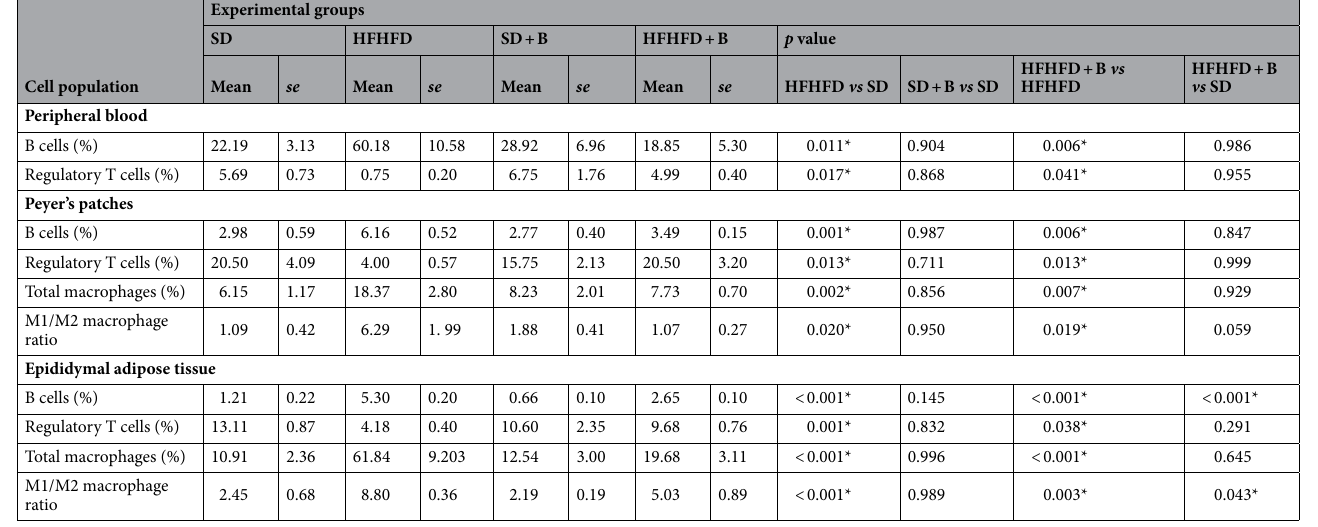
Table 1. Effects of Bacteroides uniformis CECT 7771 on adaptive and innate immunity from mice in all experimental groups. SD group: control mice received a standard diet (SD) plus placebo; HFHFD group: obese mice received a high-fat high-fructose diet (HFHFD) plus placebo; SD + B group: control mice received a SD and a daily dose of 1 × 10 8 CFU Bacteroides uniformis CECT 7771; HFHFD + B group: obese mice received are expressed as mean and standard error ( se ) of each mouse group (n = 10 per group). *Significant differences were established by ANOVA and post hoc student t test ( p < 0.050).